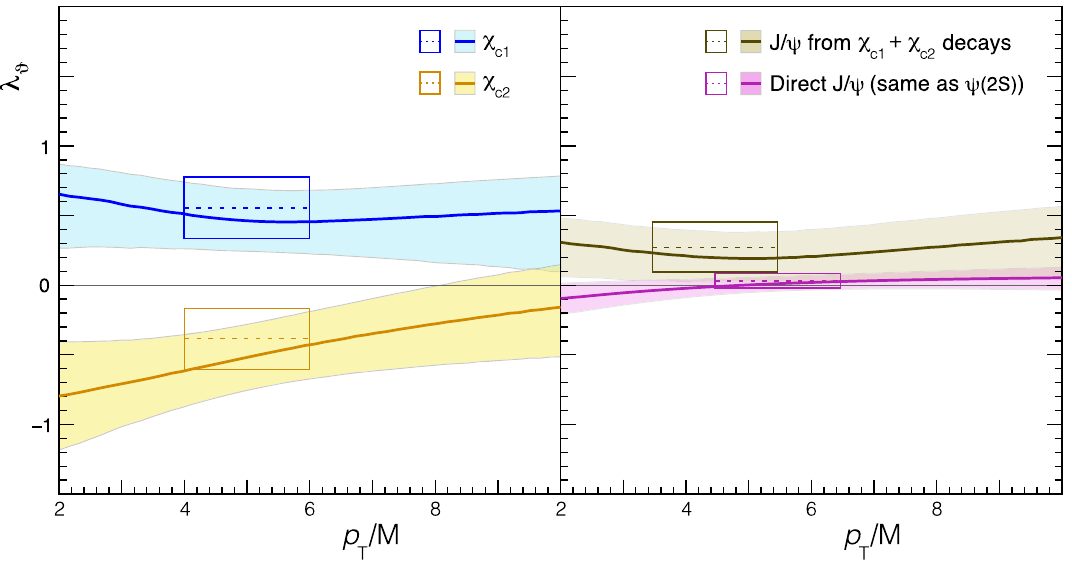
Fig. 5 The polarization parameter λ ϑ of the χ c 1 and χ c 2 mesons (left), as well as of the J /ψ mesons directly produced (same as of the ψ( 2S ) ) and produced in χ c 1 plus χ c 2 decays (right), as a function of p T /